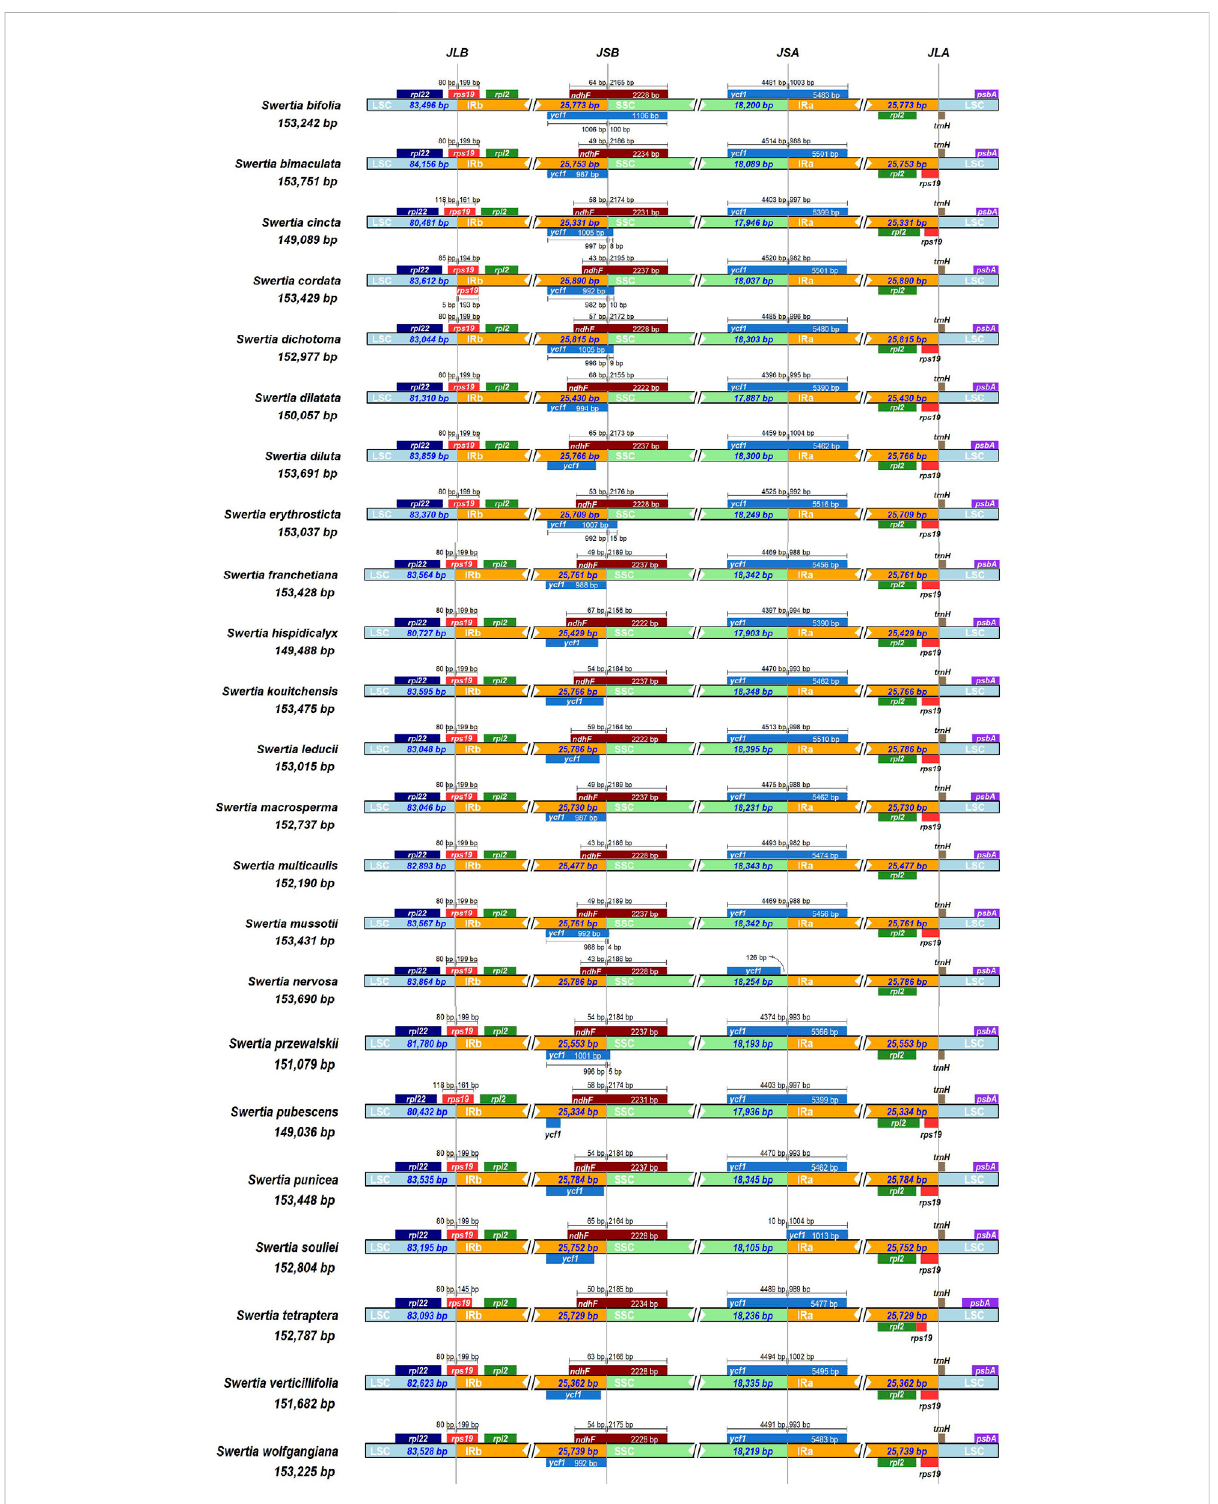
FIGURE 7 Comparative analysis of chloroplast genomic boundaries of the 23 Swertia L. plastid